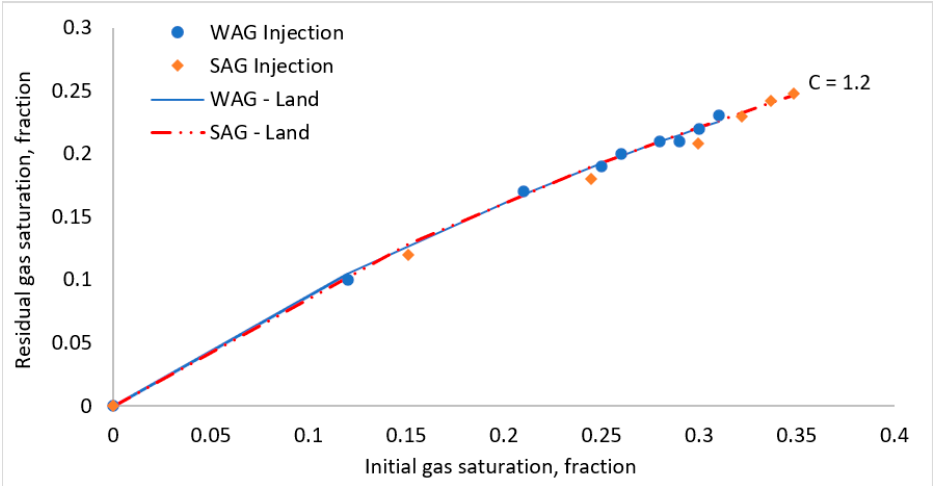
Figure 5. Initial–residual saturation curves of the AC sample under WAG injection (blue symbols) and SAG injection (orange symbols). The solid and dashed lines show the best-fit Land’s model and the corresponding values of the C coefficient for the WAG and SAG injection process, respectively.